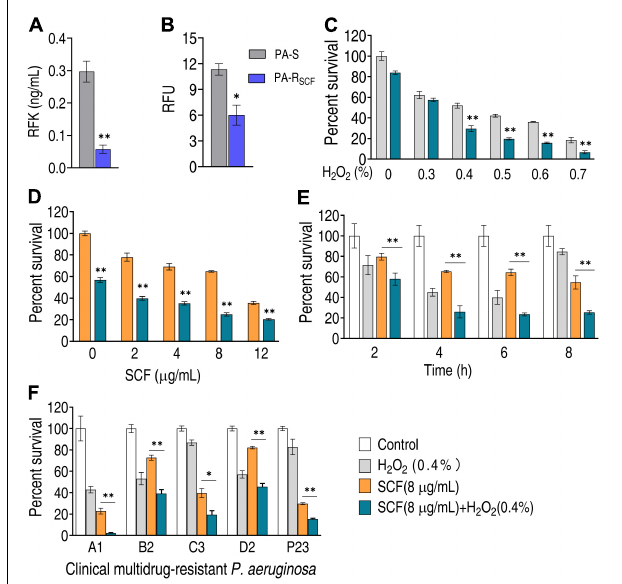
FIGURE 7 | Effect of H 2 O 2 on bacterial viability in the presence of SCF. (A) Activity of riboflavin kinase (RFK) in PA-R SCF . (B) ROS production in PA-R SCF . RFU, relative fluorescence units. (C) Percent survival of PA-R SCF in the presence of different concentrations of H 2 O 2 plus SCF. (D) Percent survival of PA-R SCF in the presence of different concentrations of SCF plus H 2 O 2 . (E) Percent survival of PA-R SCF in the presence of the indicated time plus SCF and H 2 O 2 . (F) Percent survival of clinically multidrug-resistant P. aeruginosa . Results are displayed as mean ± SEM and three biological repeats are performed. Significant differences are identified. * p < 0.05 and ** p <